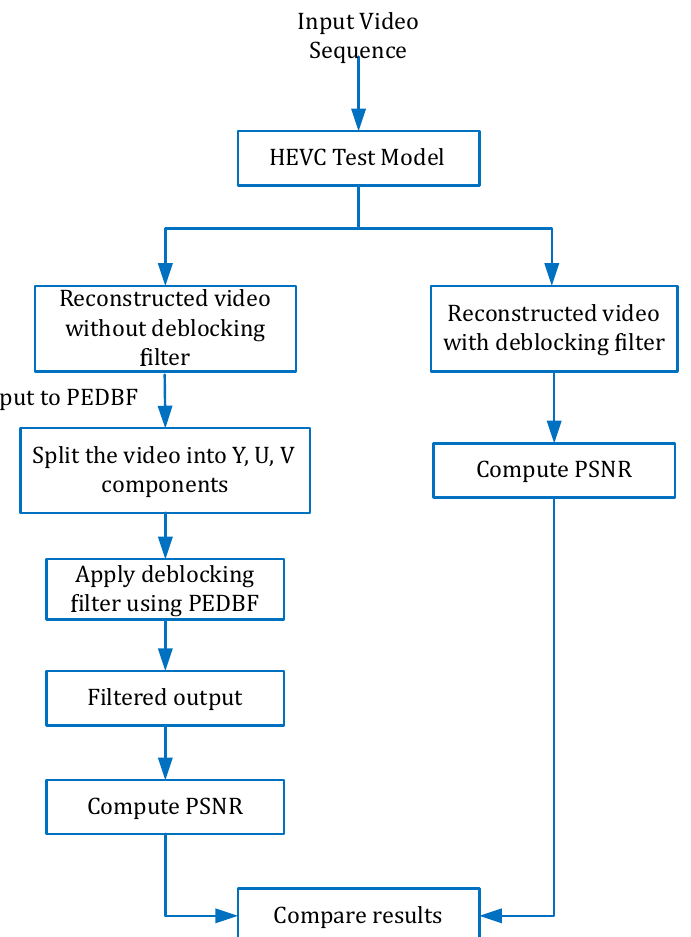
Figure 12. Flow diagram to perform quality